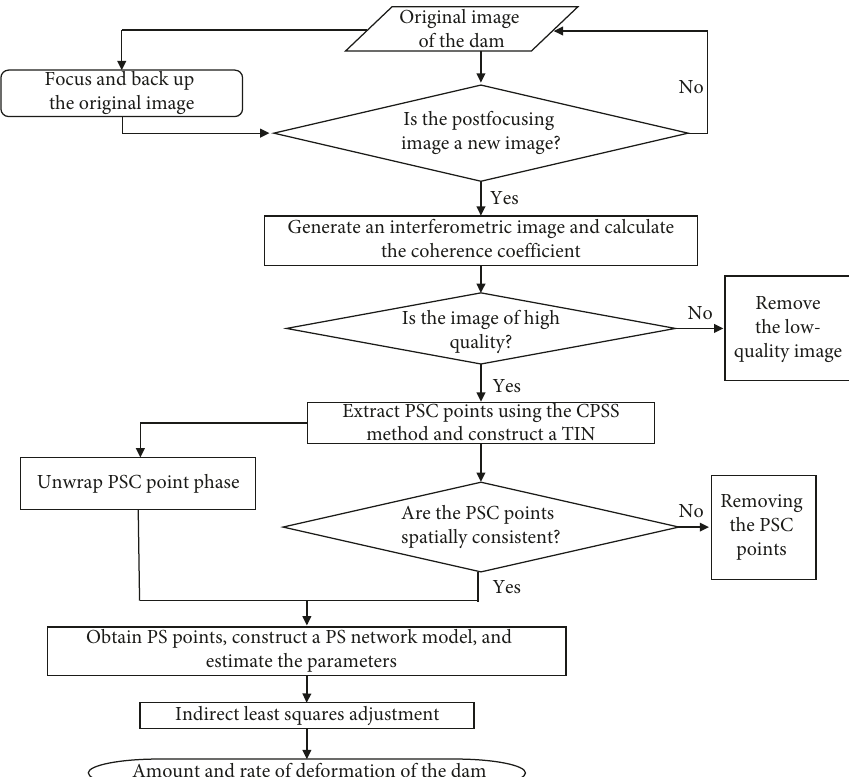
Figure 3: Research roadmap for using the CPSS method to select PS points for deformation monitoring of a